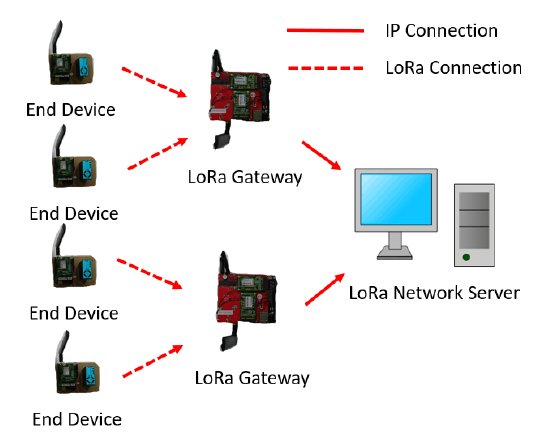
Figure 1. LoRa Network Composed of Three Different Types of